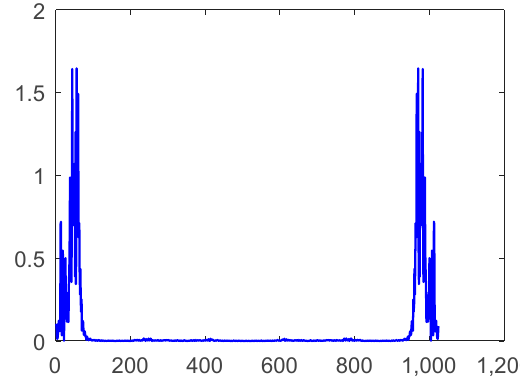
Figure 2. Short-term amplitude spectrum estimation graphs.